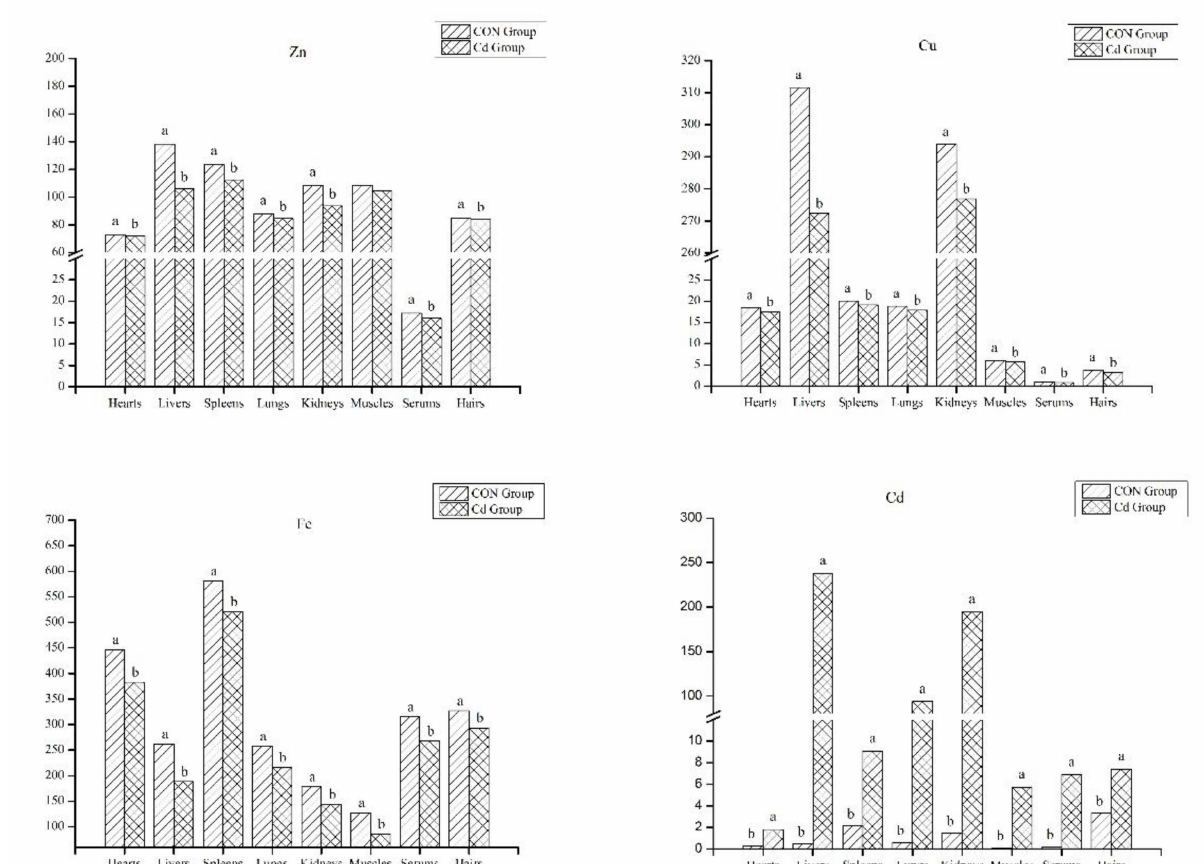
Figure 2. Mineral elements in the goat organ and tissue (ug/g). Zn, zinc; Cu, copper; Fe, iron; Cd, cadmium. Different small letters of superscript indicate significant differences ( p < 0.05), and the same small letters or no letters indicate no significant difference ( p >